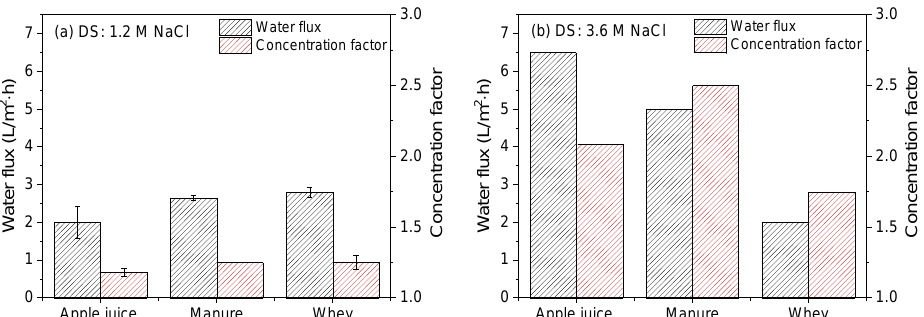
Figure 12. Water flux and concentration factor of industrial apple juice, manure or whey streams as FS and using ( a ) 1.2 M or ( b ) 3.6 M NaCl solution as DS. Average values represent two runs. Concentration time for experiments with 1.2 M NaCl as DS was 24 h, and for experiments with 3.6 M NaCl as DS: apple juice, 24 h; manure, 48 h; whey, 64 h.